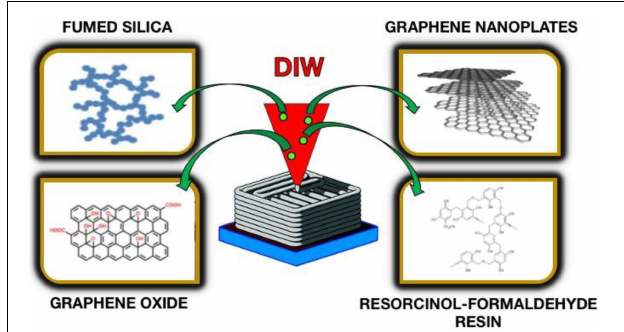
FIGURE 7 | Direct ink writing